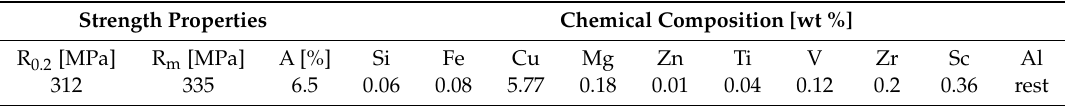
Table 1. Strength properties and chemical composition of the AA2519 alloy.